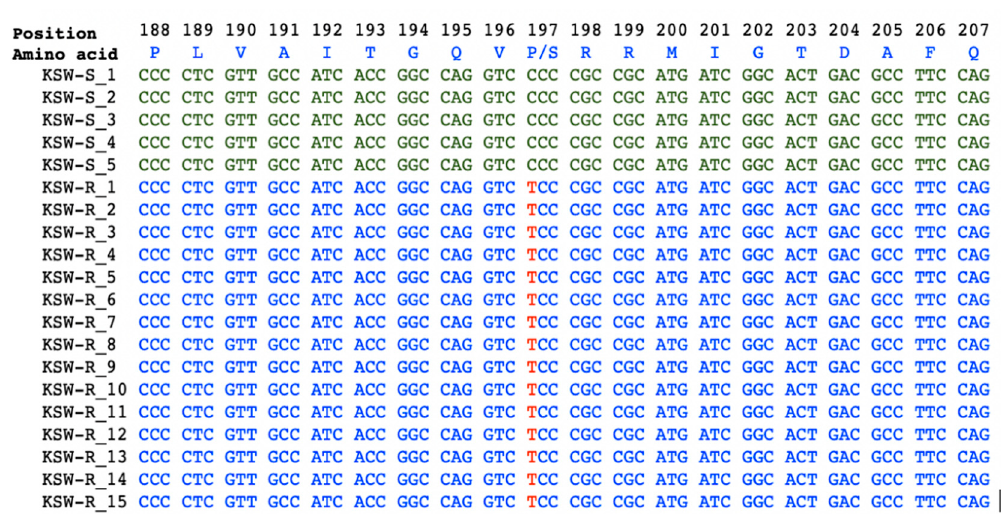
Figure 3. Nucleotide sequence alignment and analysis of a portion of the ALS gene sequence from KSW-R (15 resistant plants) and KSW-S (5 susceptible plants) wild buckwheat. Nucleotide/amino acid numbering refers to the Arabidopsis thaliana ALS gene sequence.